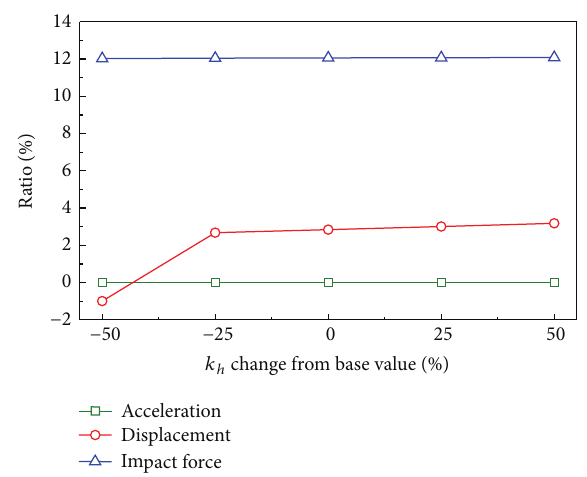
Figure 10: Effect of changing Hertz stiffness on structural response.